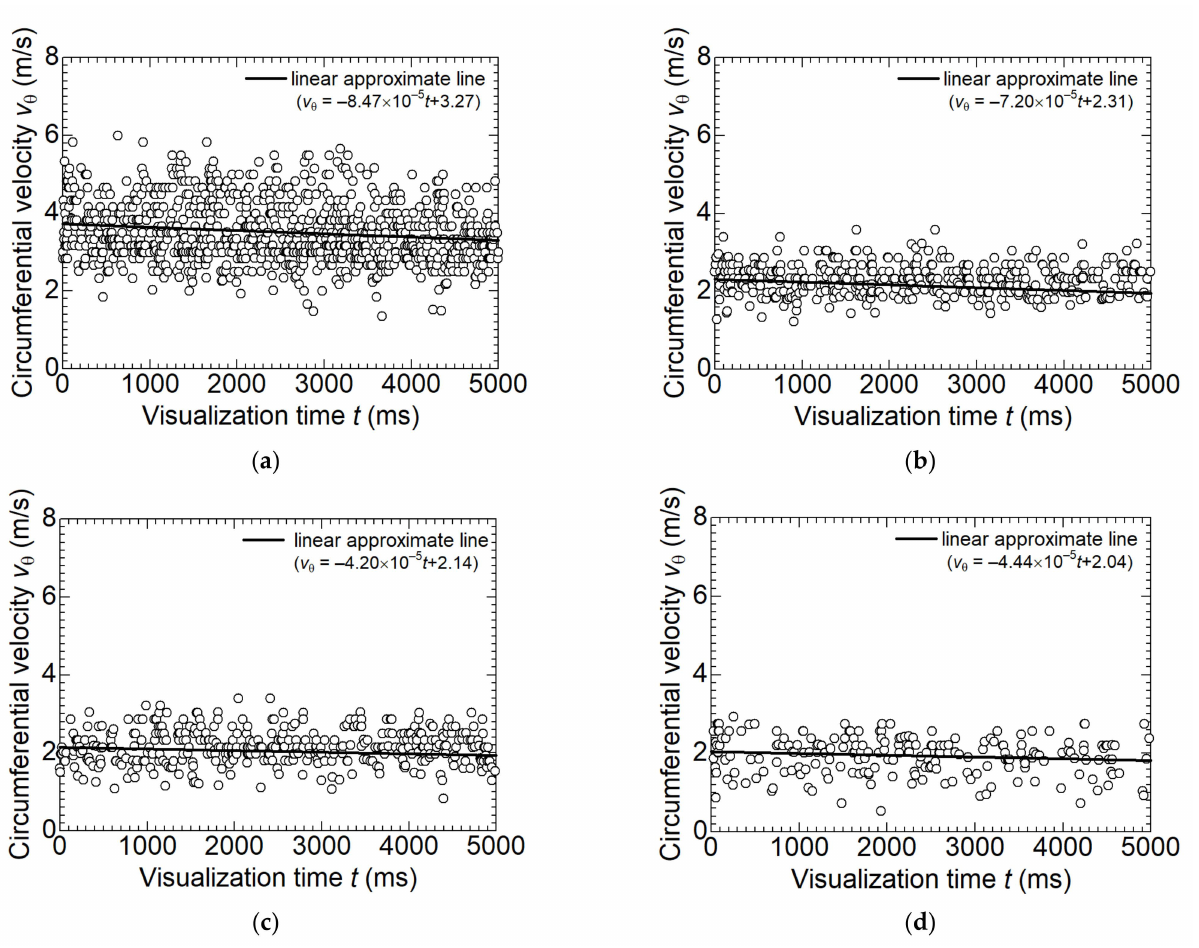
Figure 9. Time-dependent circumferential velocity v θ : ( a ) in visualization region (A); ( b ) in visualiza- tion region (B); ( c ) in visualization region (C); ( d ) in visualization region (D).